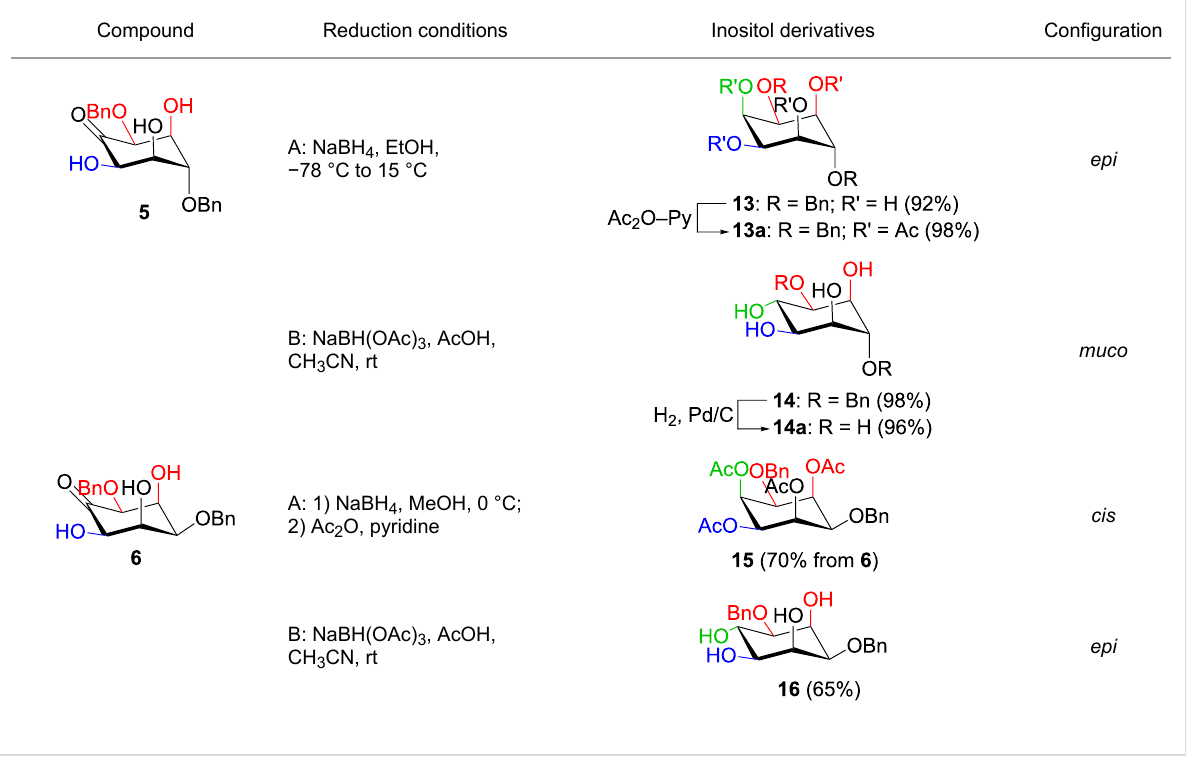
Table 2: Stereoselective complementary reductions (conditions A and B) of inososes 5–7 and 11 a,b .